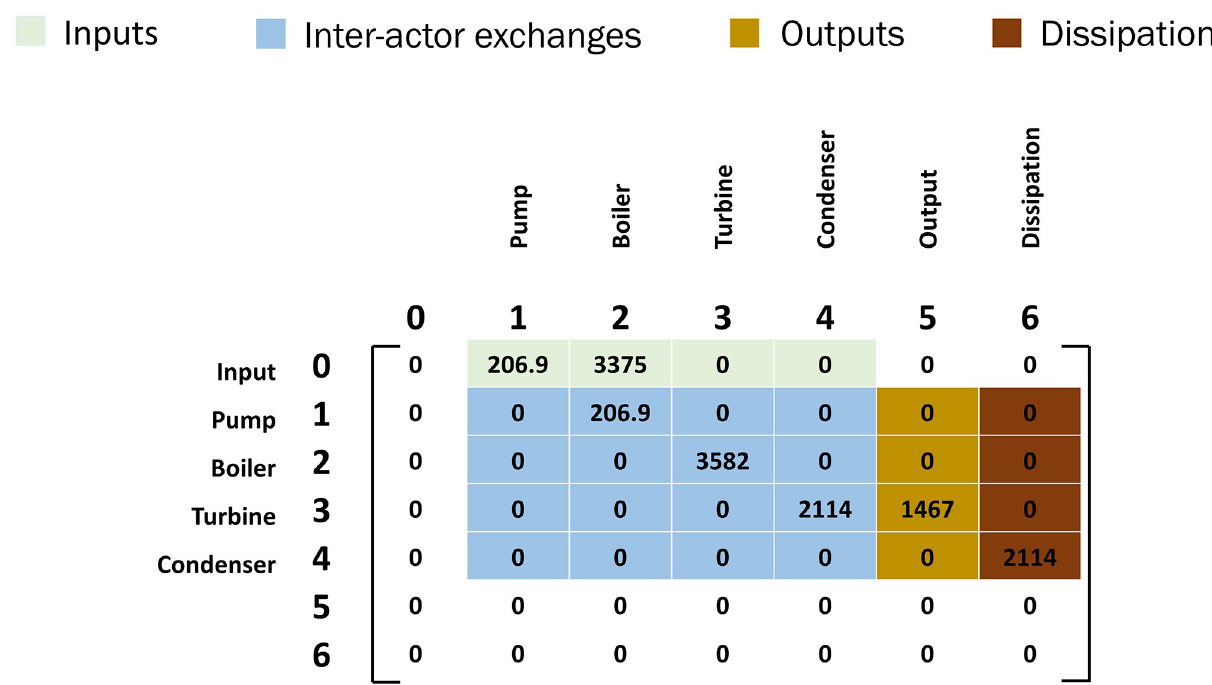
Fig 2. Flow matrix [T] for the simple Rankine cycle of Fig 1. All the flows are measured in [kJ/kg] of energy. Flow is documented as going from rows to (i) to columns (j). Row 0 is inputs to the system, column 5 contains outputs from the system and column 6 is the dissipation to the outside environment.